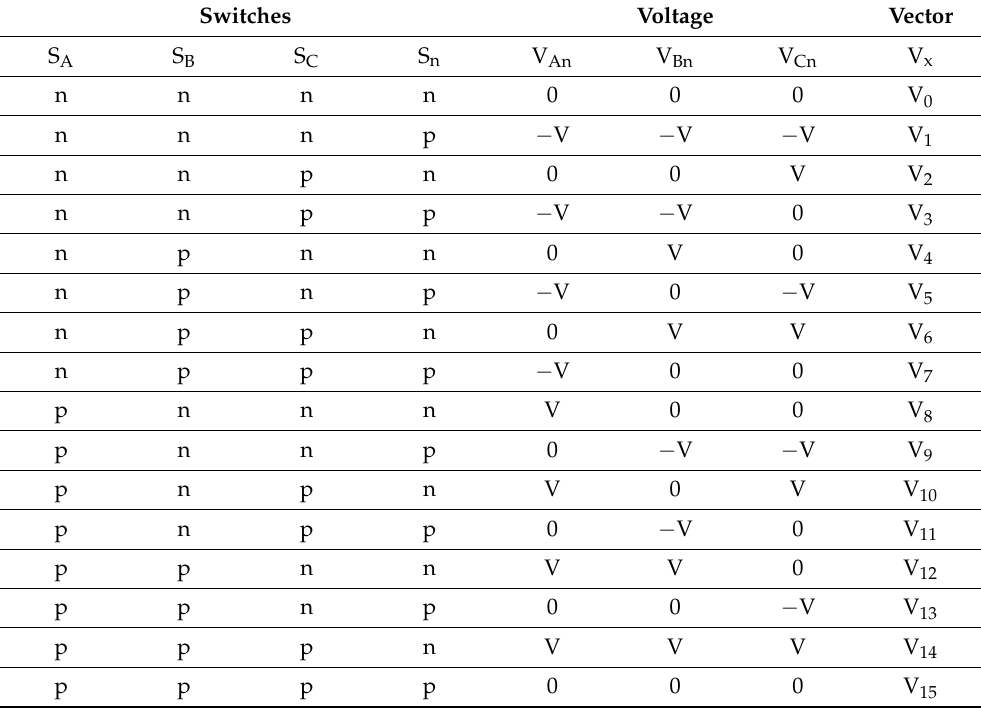
Table 1. LI Switching States with Corresponding Voltages and Vectors. Switches Voltage Vector S